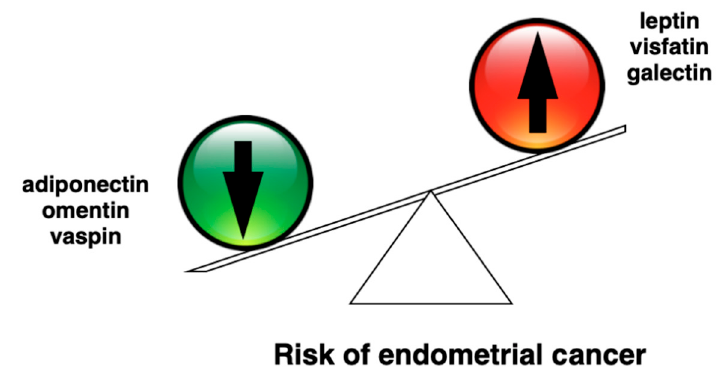
Figure 1. Changes in adipokine levels in patients with endometrial cancer (EC). The red arrows indicate elevated levels of certain adipokines in endometrial cancer, while green arrows determine the adipokines with decreased concentrations in the EC.